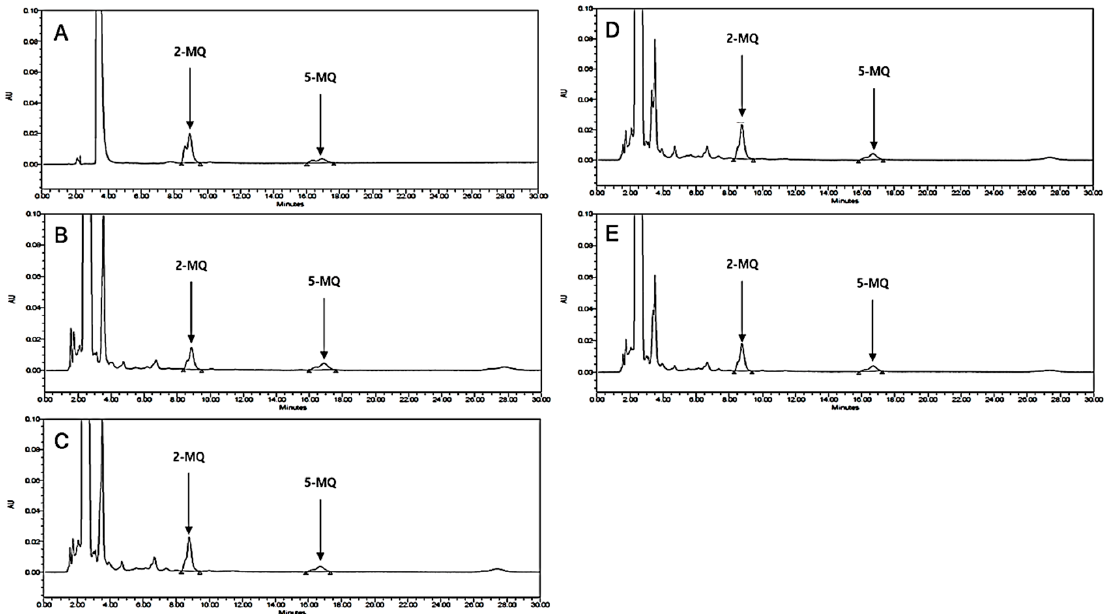
Figure 4. HPLC chromatograms of MGO in the kidneys of MGO-treated mice. ( A ) Mixture of the standard compounds. ( B ) Normal mice. ( C ) Mice treated with 300 mg / kg MGO. ( D ) Mice treated with MGO + LB (10 mg / kg). ( E ) Mice treated with MGO + LB (100 mg / kg). Table 1. MGO levels in MGO-treated mouse kidneys Sample